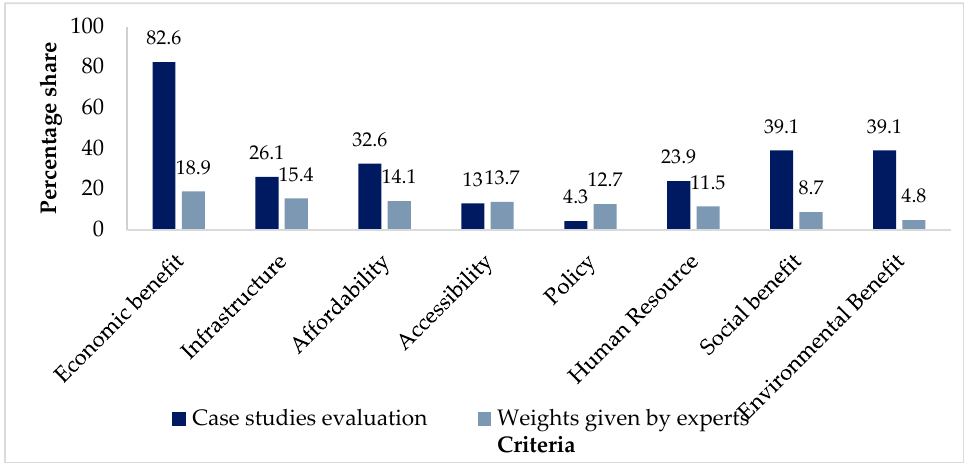
Figure 10. Total number of case studies considering each of the eight criteria.